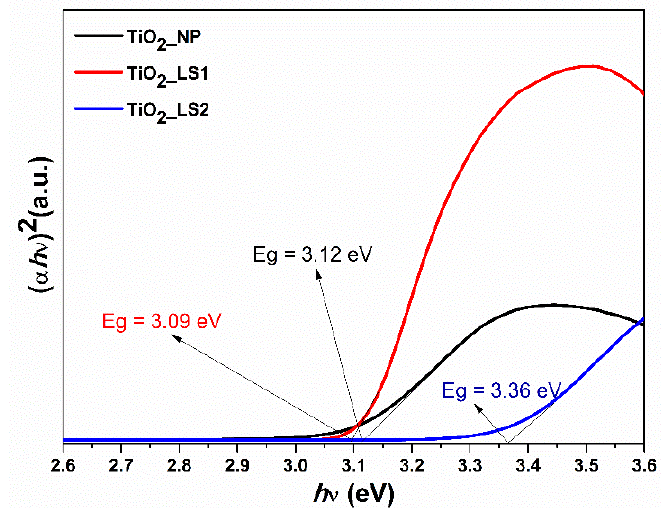
Figure 6. Band gaps of TiO 2 _NP, TiO 2 _LS1, and TiO 2 _LS2 photoelectrode materials calculated from the diffuse reflectance spectra.